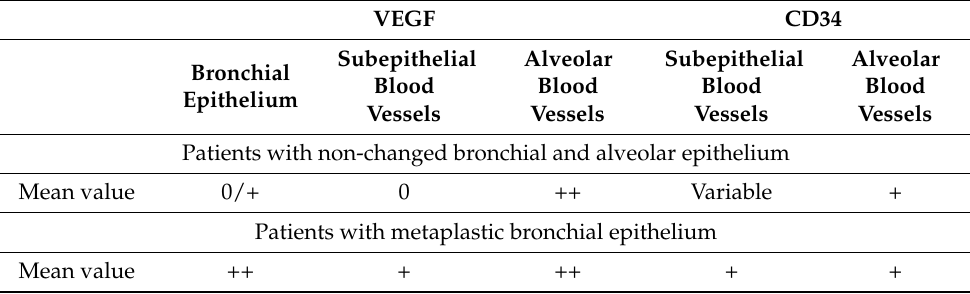
Abbreviations: “0”—no positive structures (0%) seen in the visual field; “0/+”—occasional positive structures (12.5%); “+”—few positive structures (25%) seen in the visual field; “++”—moderate number of positive structures (50%) seen in the visual field; “VEGF”—vascular endothelial growth